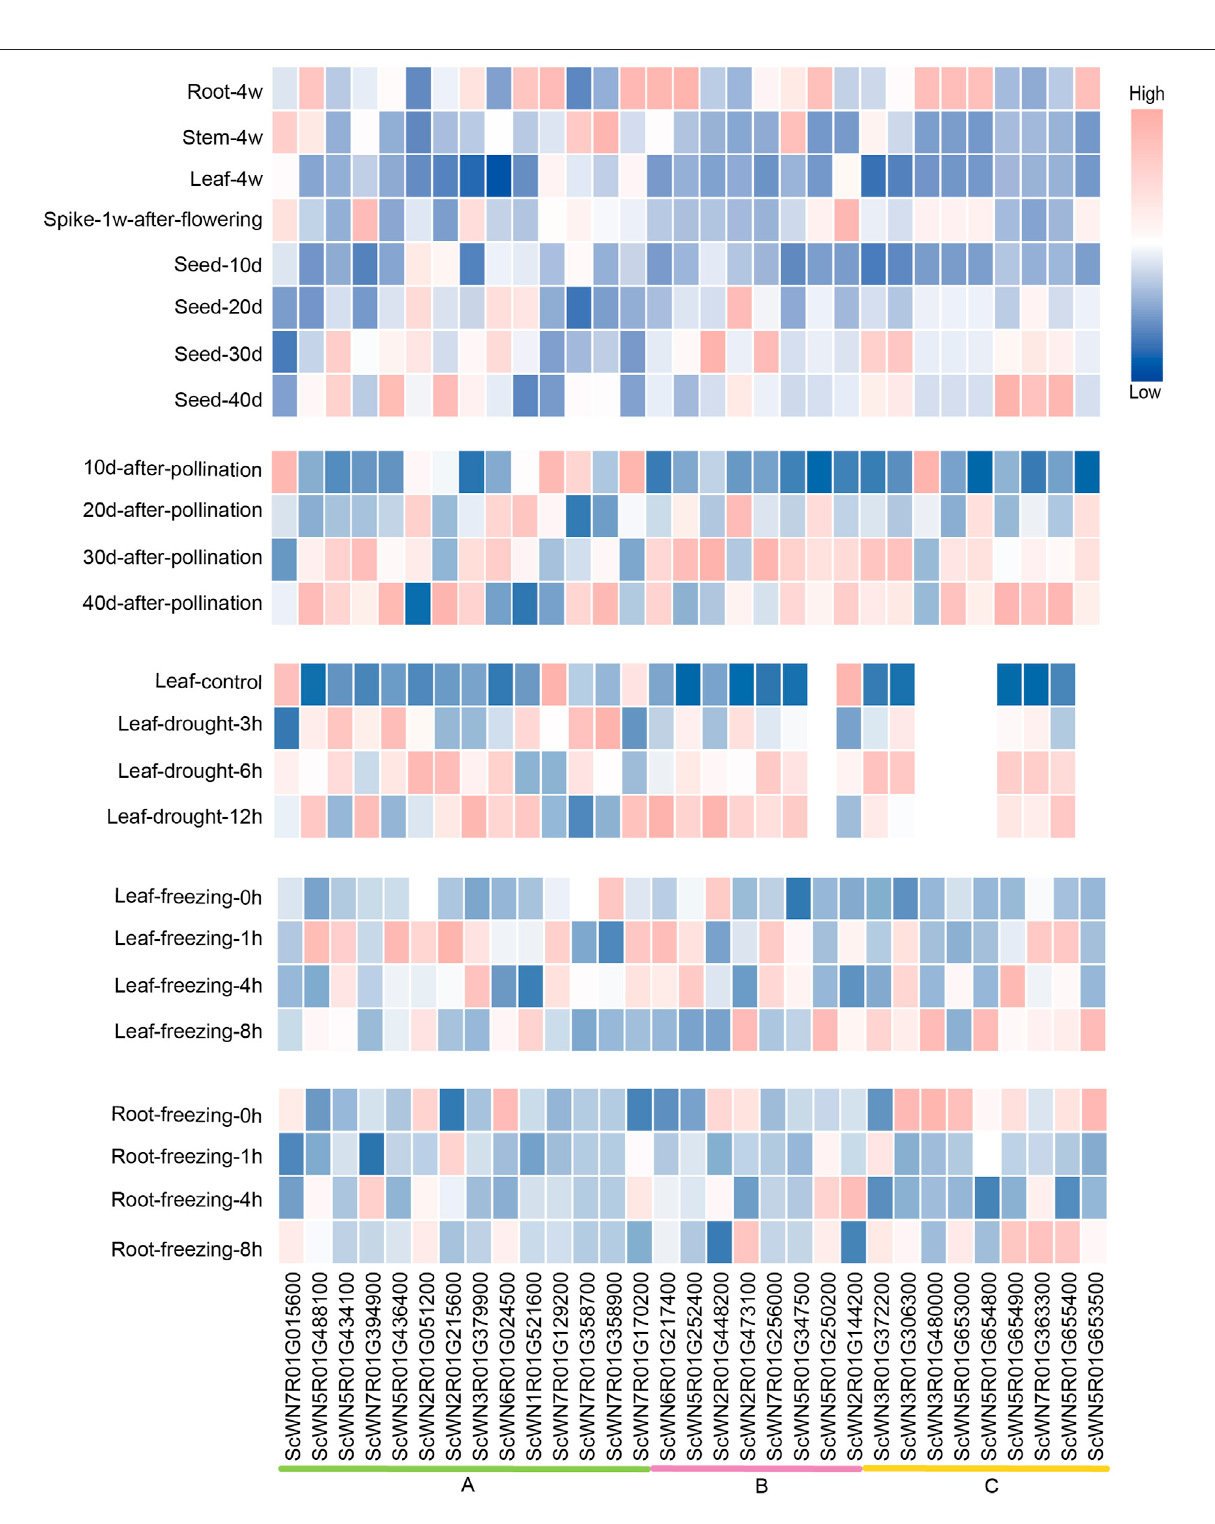
Frontiers in Genetics |